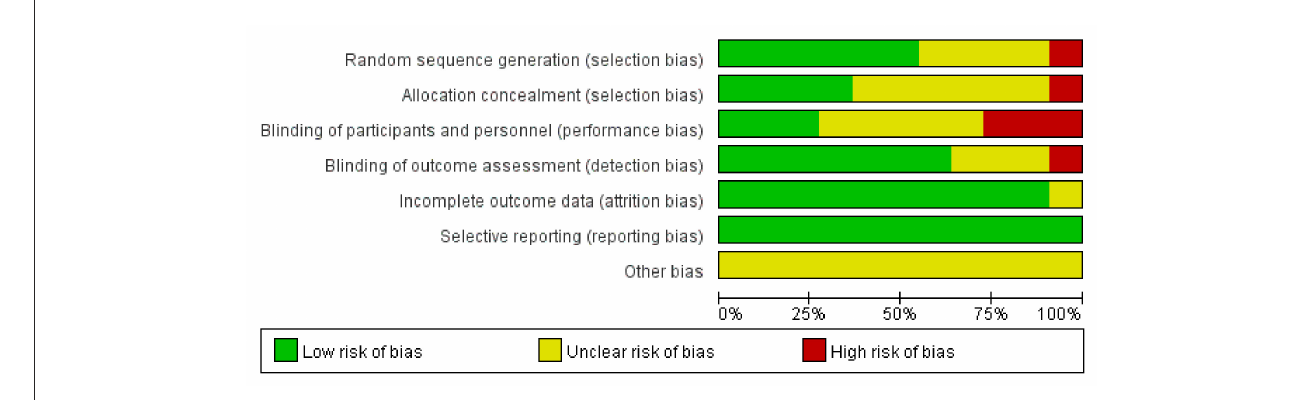
FIGURE4 Bias risk bar